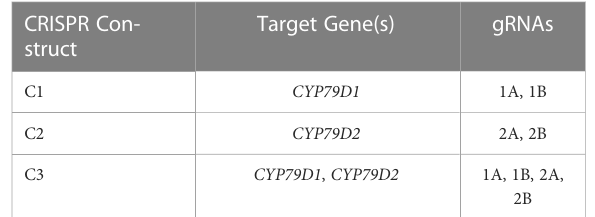
TABLE 1 CRISPR constructs used in this